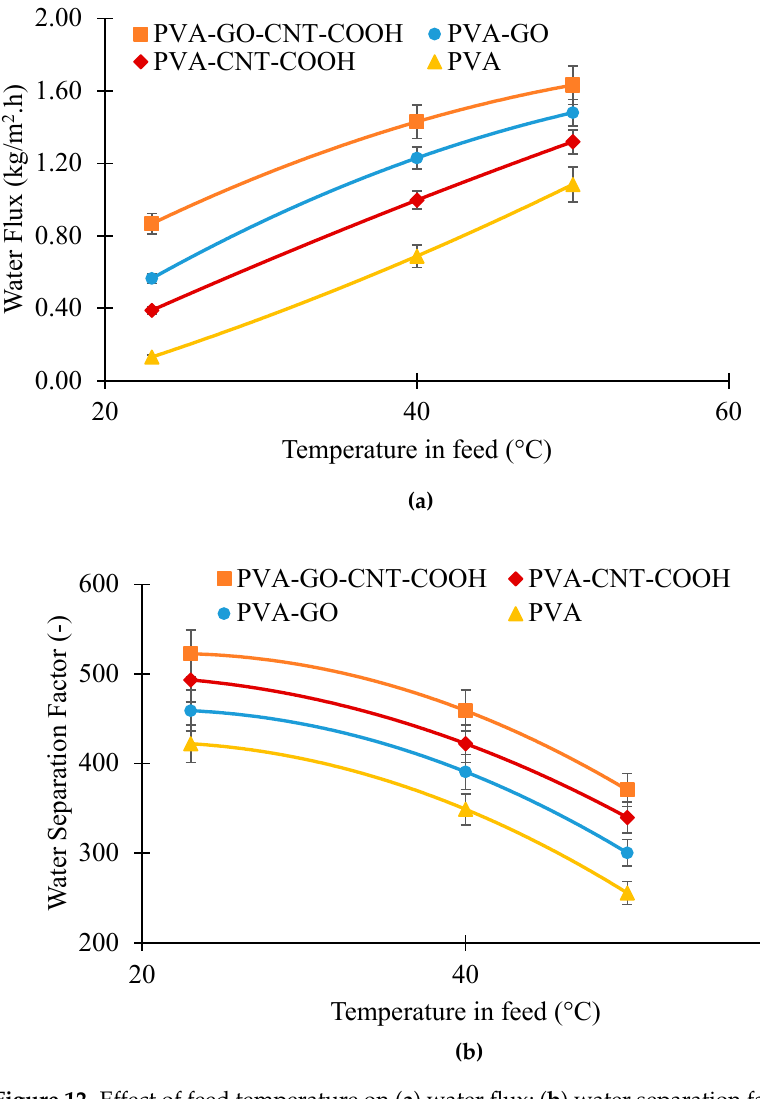
Figure 12. Effect of feed temperature on ( a ) water flux; ( b ) water separation factor at 10 wt.% water in feed.